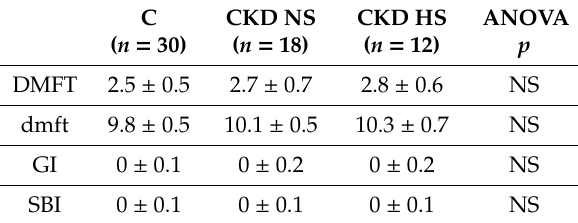
Table 2. Dental examination of children with chronic kidney disease (CKD) and healthy